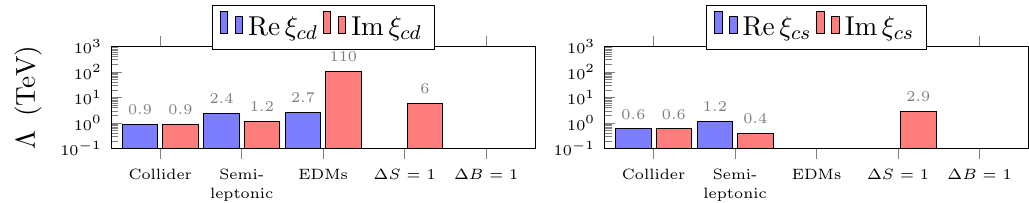
Figure 7 . The (cid:12)gure shows naive constraints on (cid:24) cd and (cid:24) cs . Notation is the same as in (cid:12)gure 6.